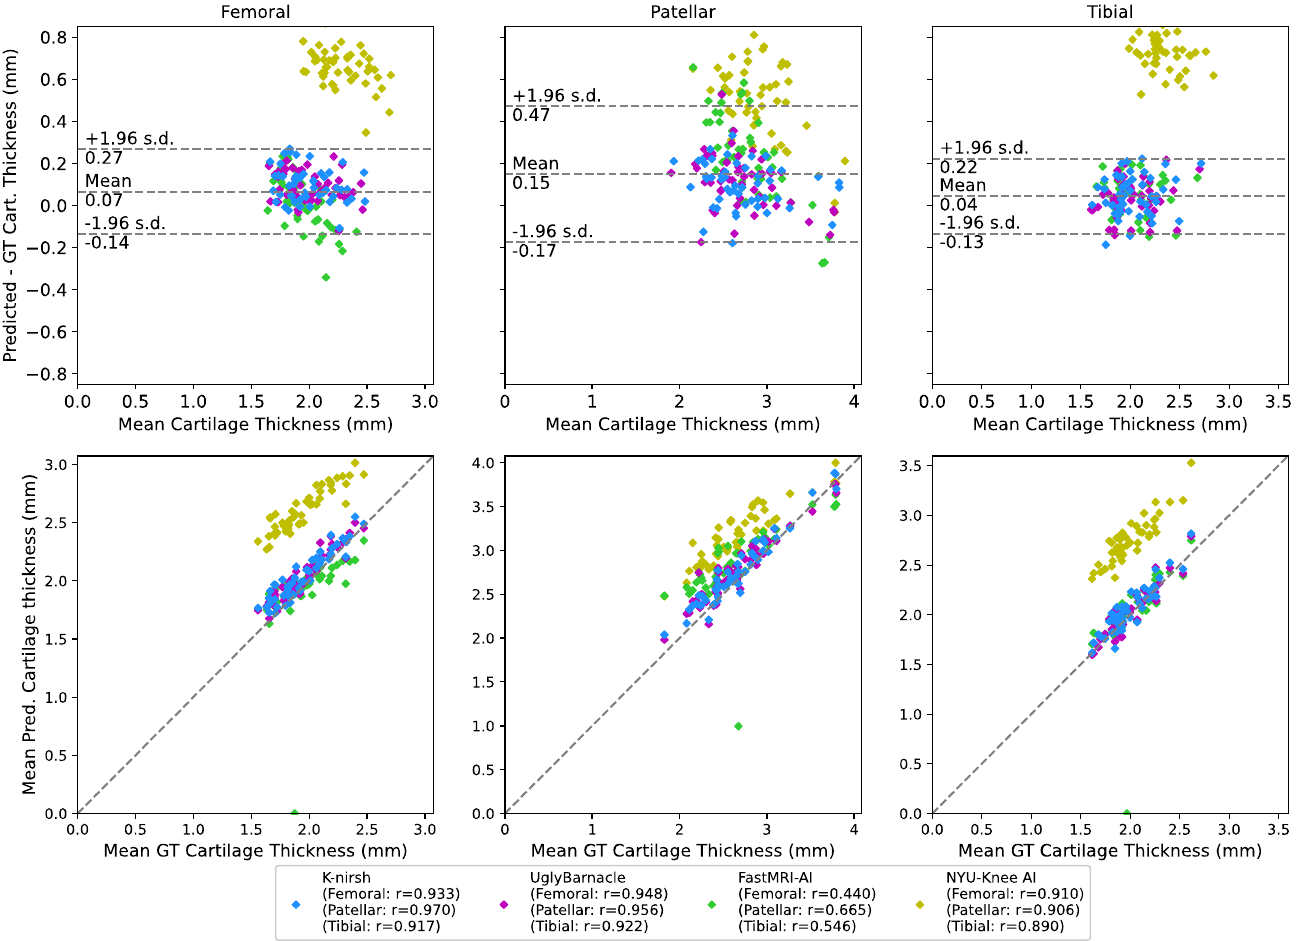
Figure 10. Bland-Altman and correlation plots between predicted and ground truth cartilage thicknesses for each of the top 4 submissions, across each of the 3 cartilage compartments. The mean and standard deviations for these plots were calculated using the data points from K-nirsh, UglyBarnacle, and FastMRI-AI, given the thickness overestimations seen from NYU-Knee AI. The top three submissions saw minimal bias and strong fidelity to ground truth, while NYU-Knee AI appeared to slightly overestimate particularly tibial and femoral cartilage thicknesses. That said, correlation plots showed strong correlations between predicted and ground truth thicknesses for K-nirsh, UglyBarnacle, and NYU-Knee AI. FastMRI-AI visually appeared to have strong correlation as well, but an outlier case appears to have severely degraded the correlation coefficient. All told, these results collectively are quite promising that submissions are suitable for some downstream biomarker analysis.